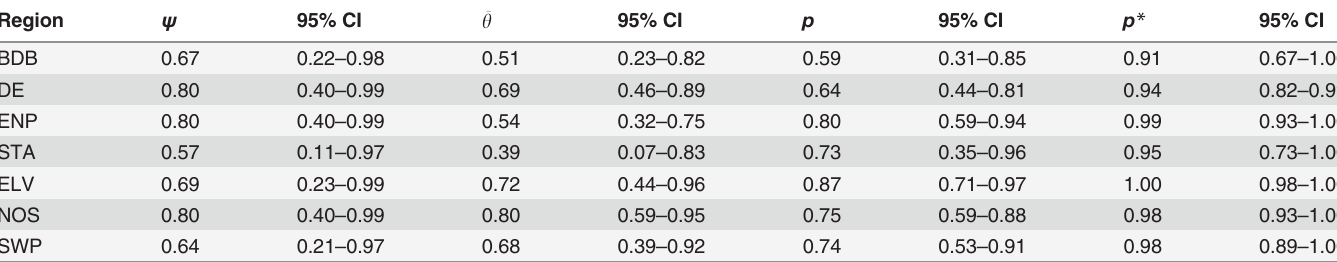
Posterior mean and 95% credible interval (CI) are given for each parameter of the occupancy model. Average conditional probability of occurrence of (cid:2) y (cid:2) ). Cumulative probability of detecting eDNA in three quantitative PCR replicates ( p * ). BDB, Bird Drive Basin; Burmese python eDNA in a single sample ( DE, Deering Estates; ENP, Everglades National Park; HLWM, Holey Lands Wildlife Management Area; STA, Stormwater Treatment Area 5; and radiotagged snakes: ELV, Elvis; NOS, Noosa; and SWP, Sweet